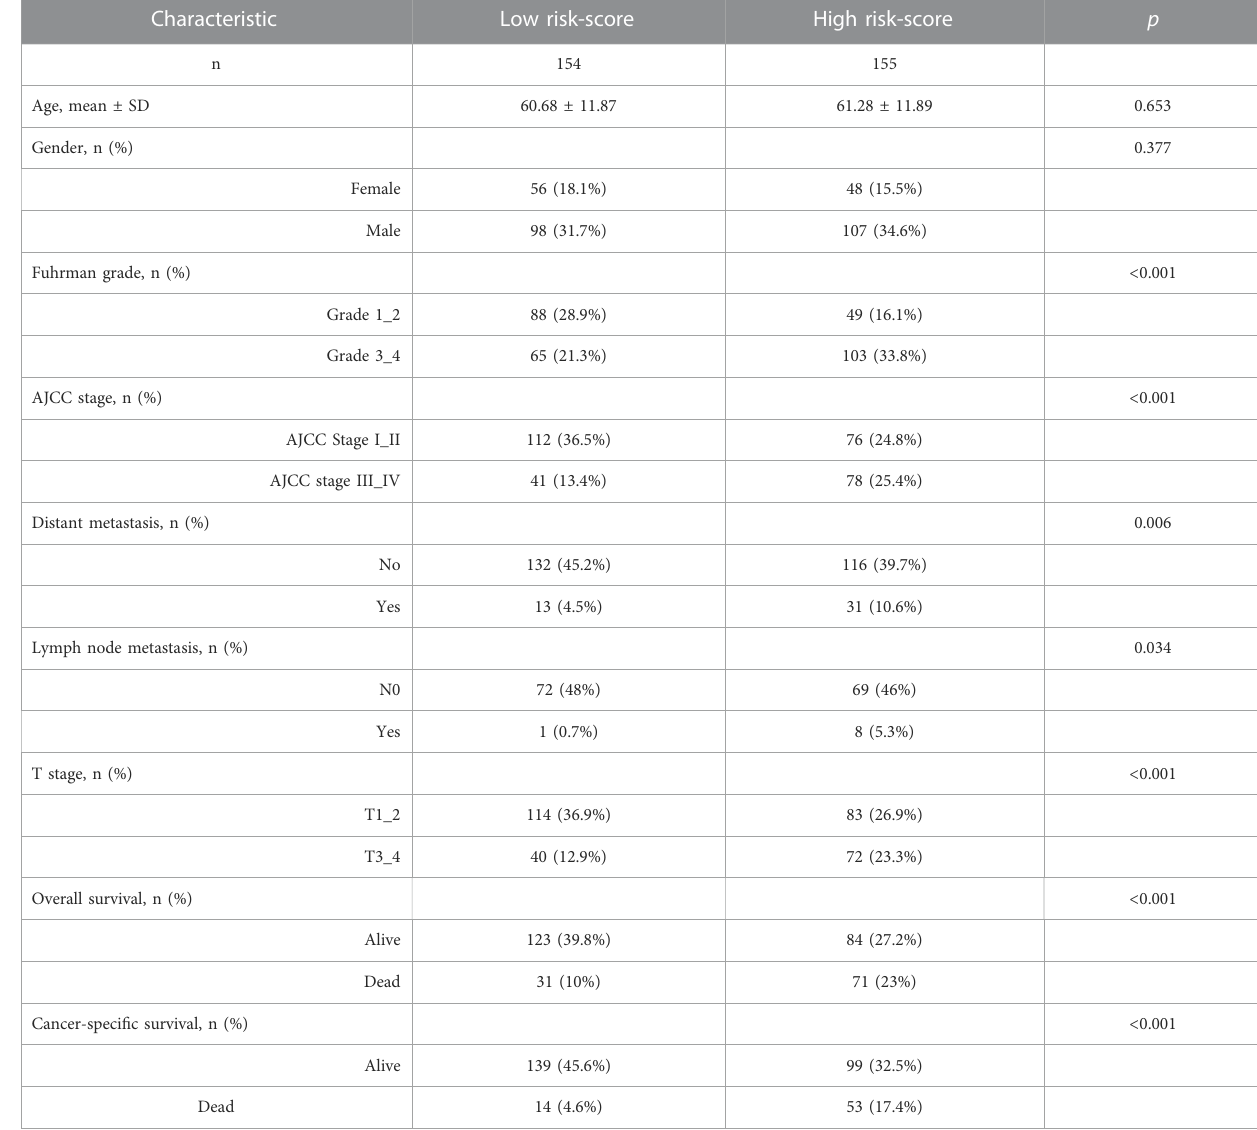
TABLE 1 Clinicopathologic characteristics of the TCGA training